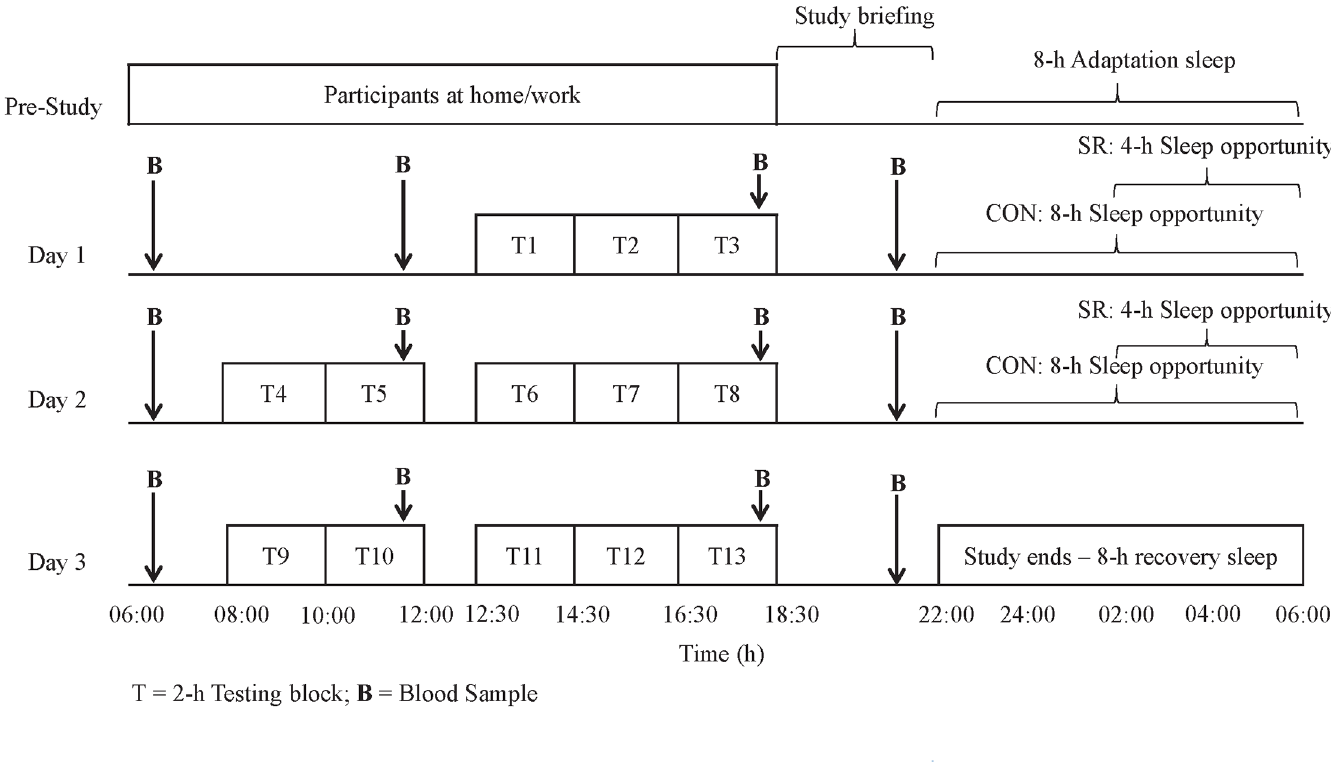
Fig 1. Firefighting work protocol for CON and SR